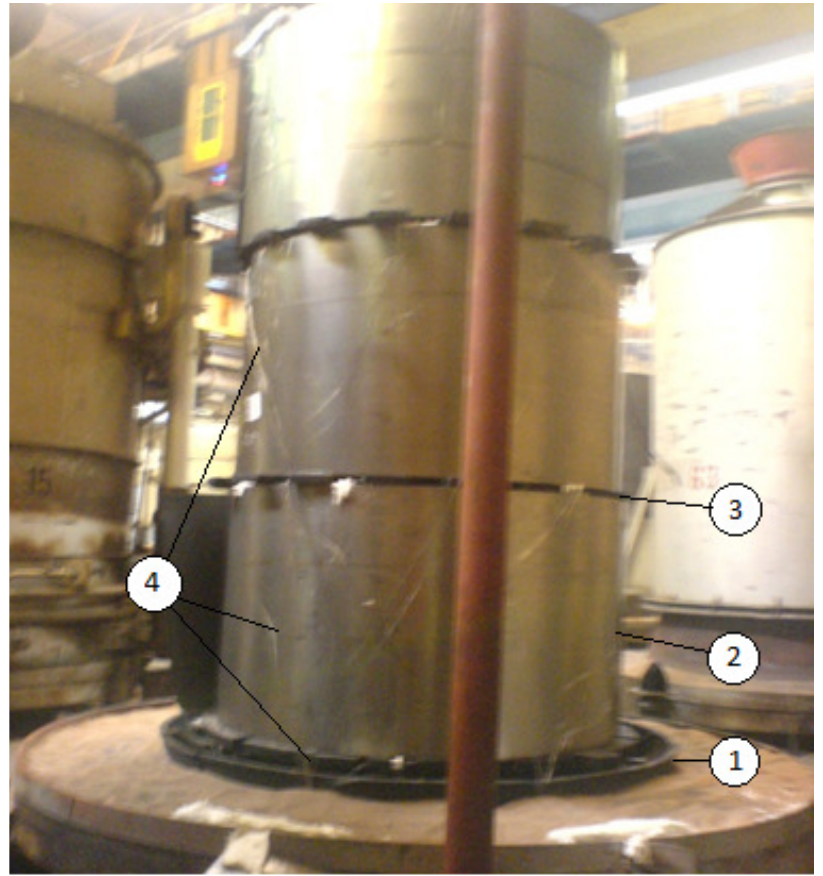
Figure 4. Measuring points of the coil in experimental measurement.